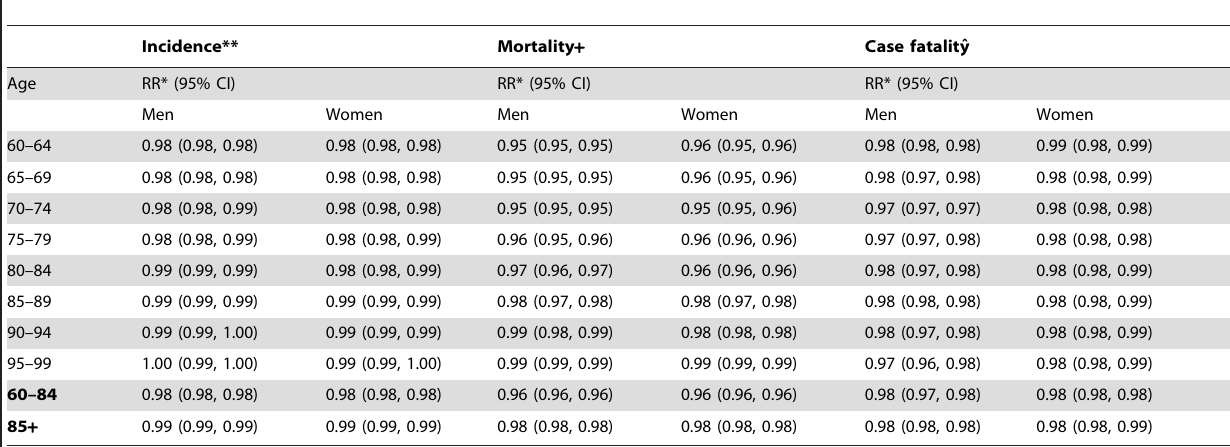
Table 1. Average annual change in CVD between 1994 and 2010, ages 60–99 years, men and women.